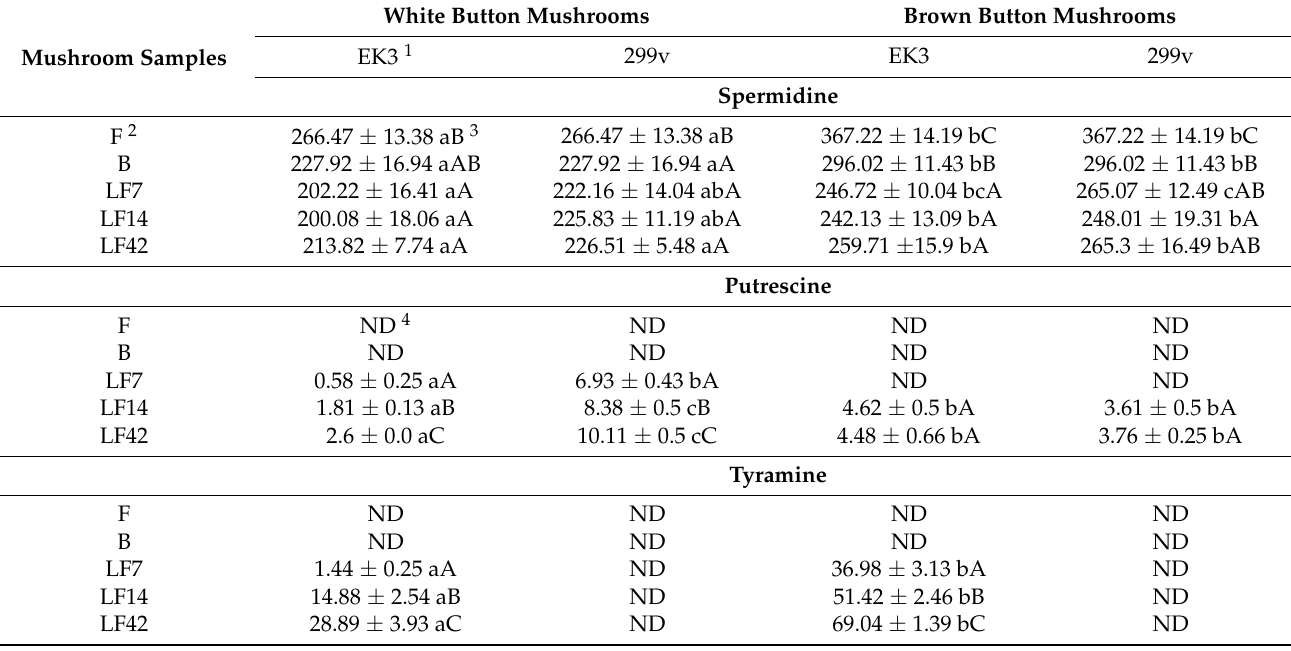
Table 1. Content of biogenic amines in the mushrooms